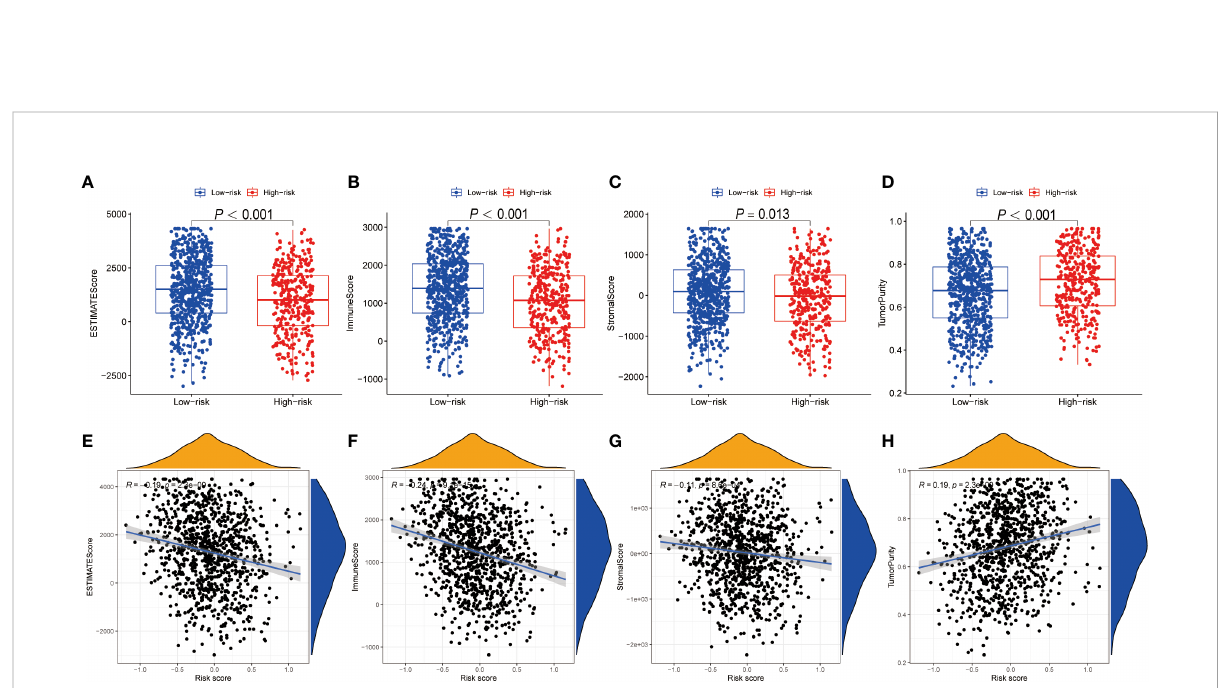
FIGURE 5 TME discrepancy between high- and low-risk groups. (A – H) The box plot shows the ESTIMATE score (A) , immune score (B) , stromal score (C) and tumor purity (D) of the high- and low-risk NSCLC patients. The correlation analysis between the ESTIMATE score (E) , immune score (F) , stromal score (G) as well as tumor purity (H) and the risk score in NSCLC patients, respectively. TME, tumor microenvironment; NSCLC, non- small cell lung